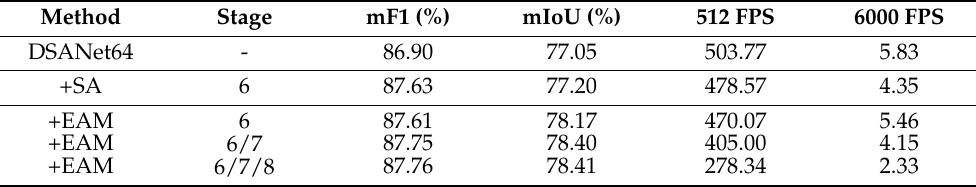
Table 4. Comparison of the EAM Results Obtained on the Potsdam Dataset in Different Stages.